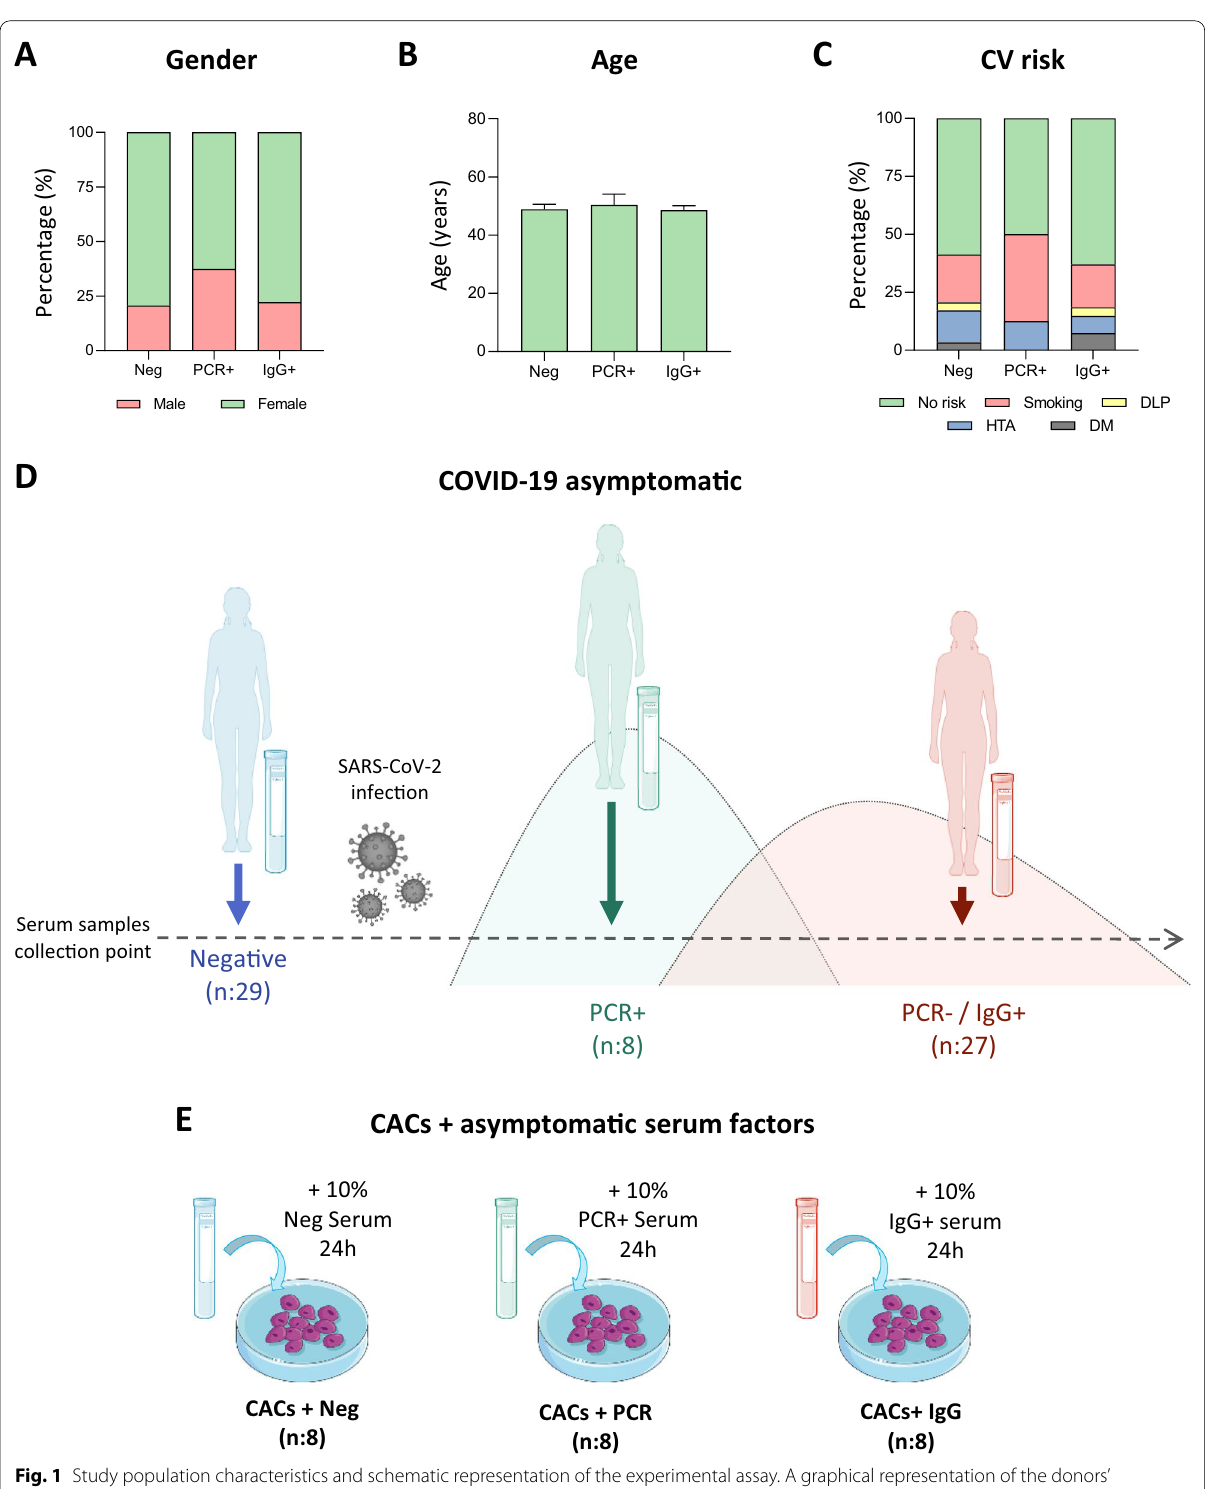
Fig. 1 Study population characteristics and schematic representation of the experimental assay. A graphical representation of the donors’ characteristics is shown, including A Gender, B age and C Cardiovascular (CV) risks reported for each group. D Schematic representation of the infective stage of asymptomatic individuals at the time of serum extraction. Individuals were classified as COVID‑19 negative (PCR or COVID‑19 positive, at the peak of infection (PCR serum of COVID‑19 negative donors, or with the serum of COVID‑19 PCR